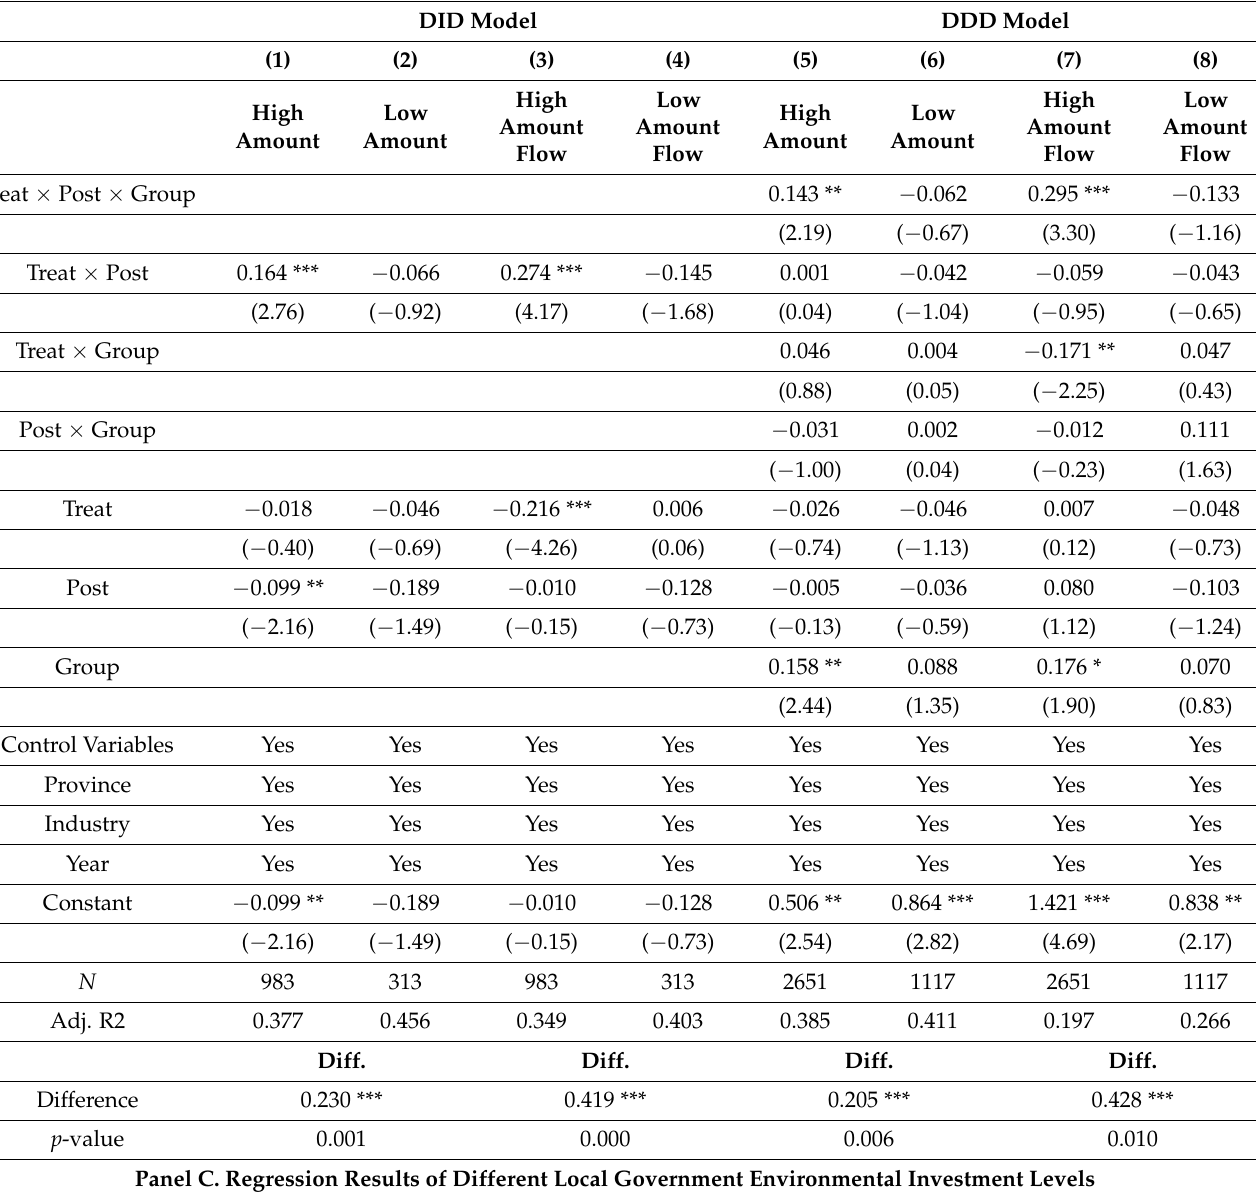
Panel B. Regression Results of Different Financial Development